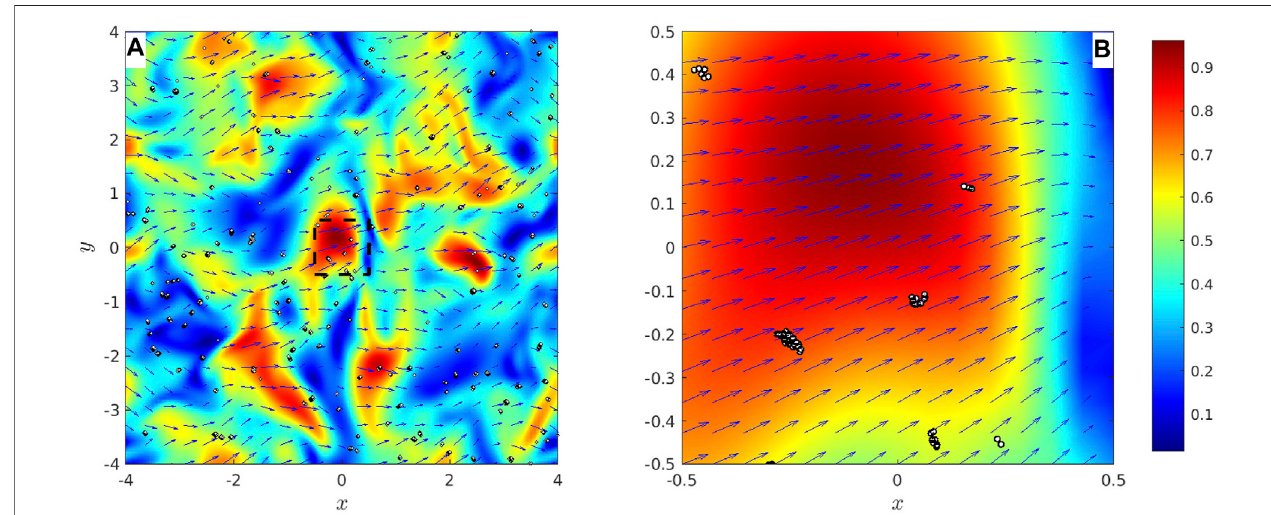
FIGURE 2 | Model results. (A) Horizontal ( x – y ) plane of the fl ow fi eld with particles from case P 1 S 1 with relatively larger primary particles. The streamwise velocity component is used as background color. (B) Zoom in view of the velocity fi eld and particles [black box in panel (A) ].